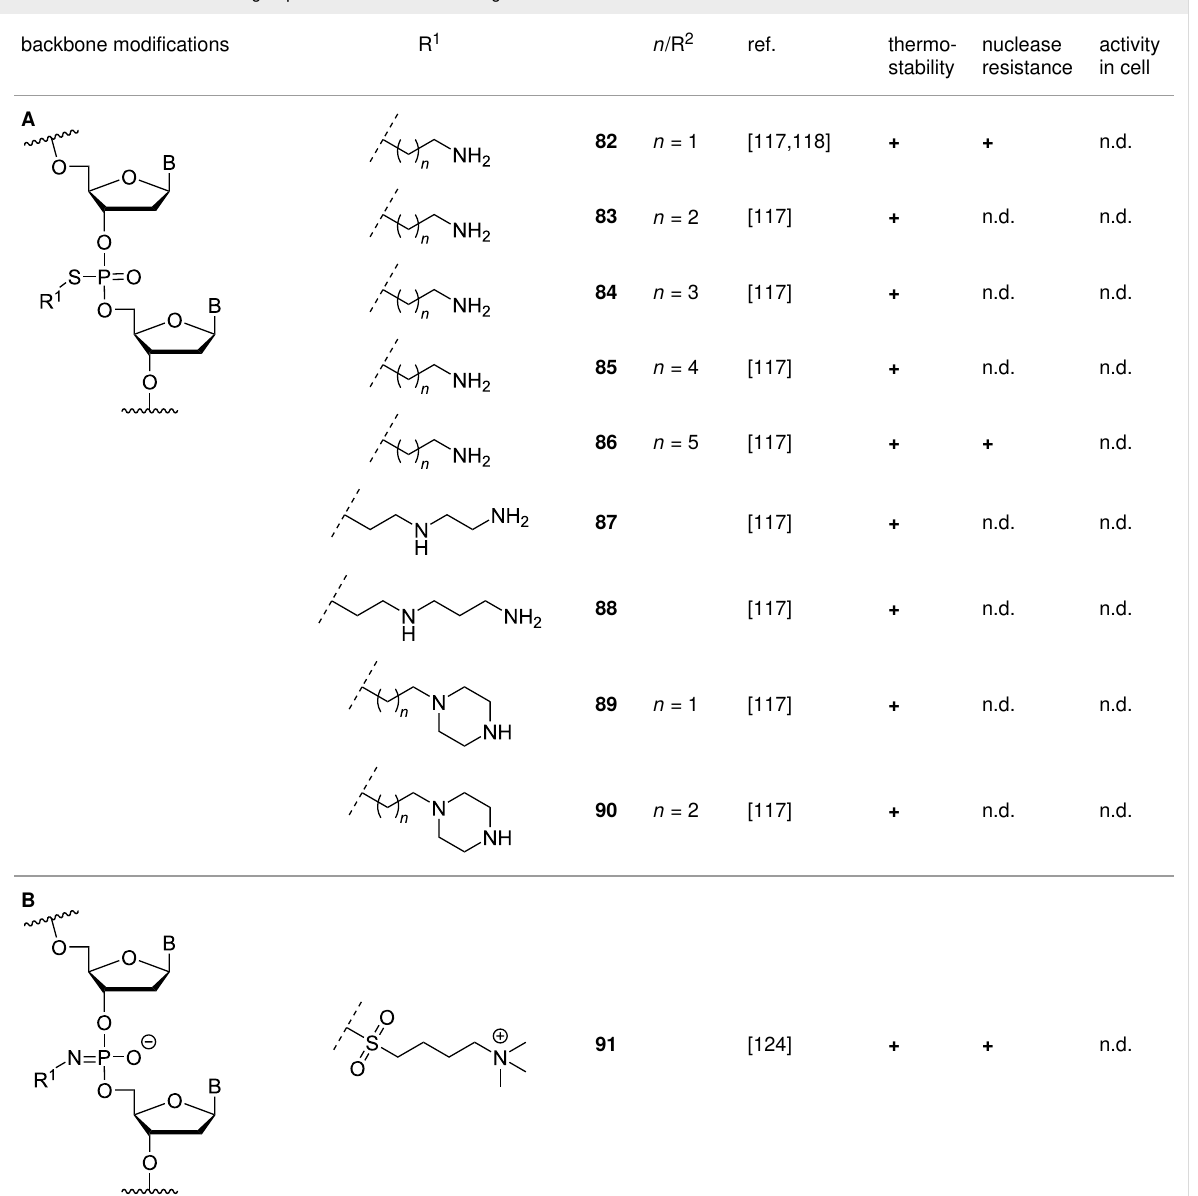
Table 9: Amine-functionalized groups as internucleoside linkage.